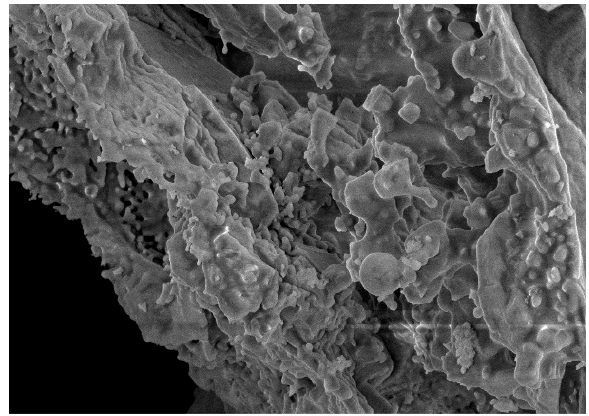
Figure 4. SEM diagram of RHA at 5000 times.